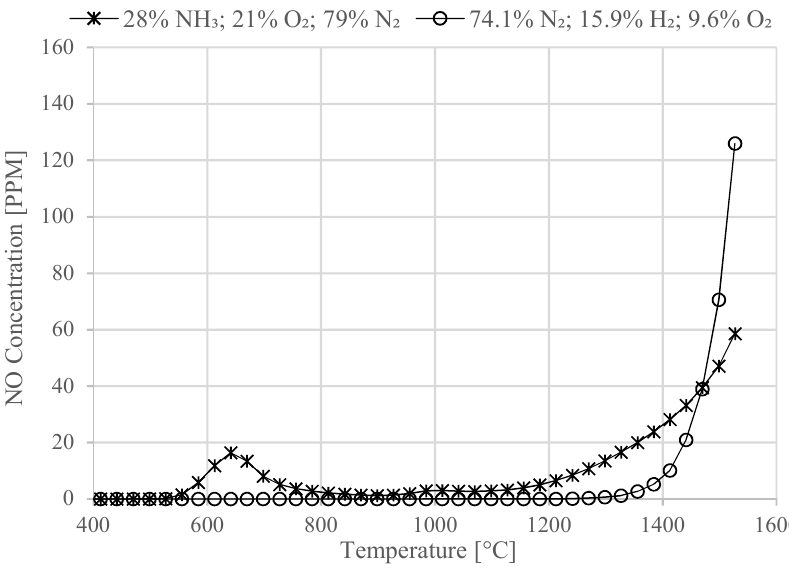
Figure 5. Concentration of NO in ppm in the afterburner outlet gases due to NH 3 /H 2 /air combustion. One case refers to the combustion of ammonia during the system startup, while the other curve refers to the H 2 /air combustion.